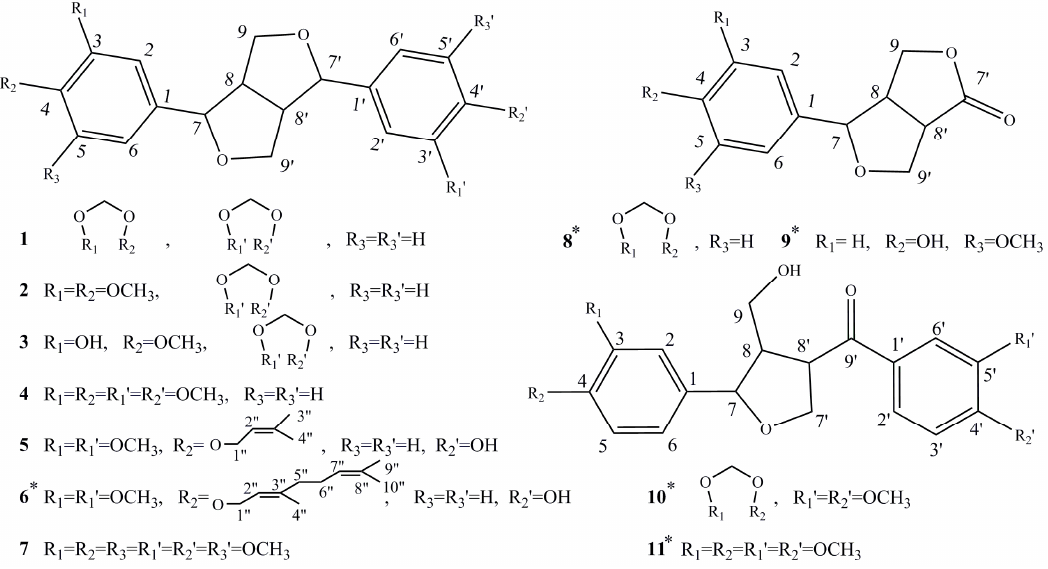
Figure 1. Chemical structures of compounds 1 – 11 . * represents known but derived from the plant of Zanthoxylum armatum for the first time. Zanthoxylum armatum for the first